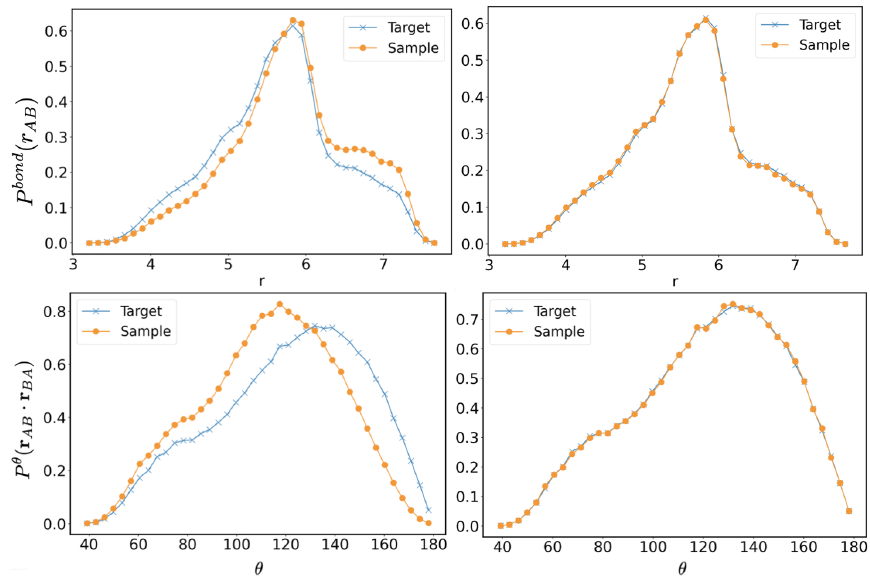
Figure 3. Short-range distributions obtained in AA simulation compared to CG ones (distance in Å). In the left panels, the coarse-grained distributions in the first step of the IBI procedure are reported, and in the right panels, the distributions in the final